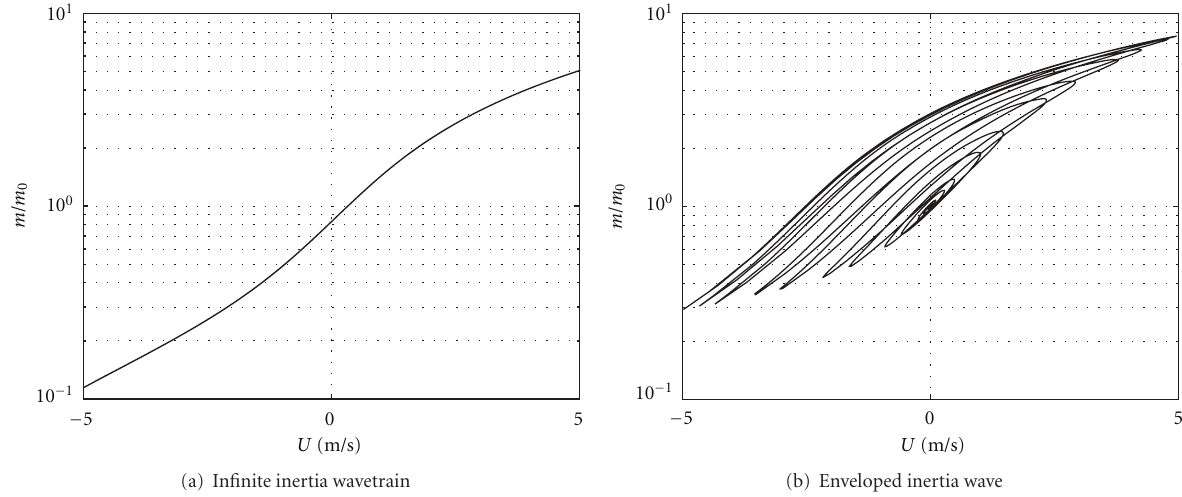
Figure 5: Normalized vertical wavenumber of a short wave with m 0 /μ = 10 and k/μ = − 1 as it propagates through an inertia wave with U 0 = 5